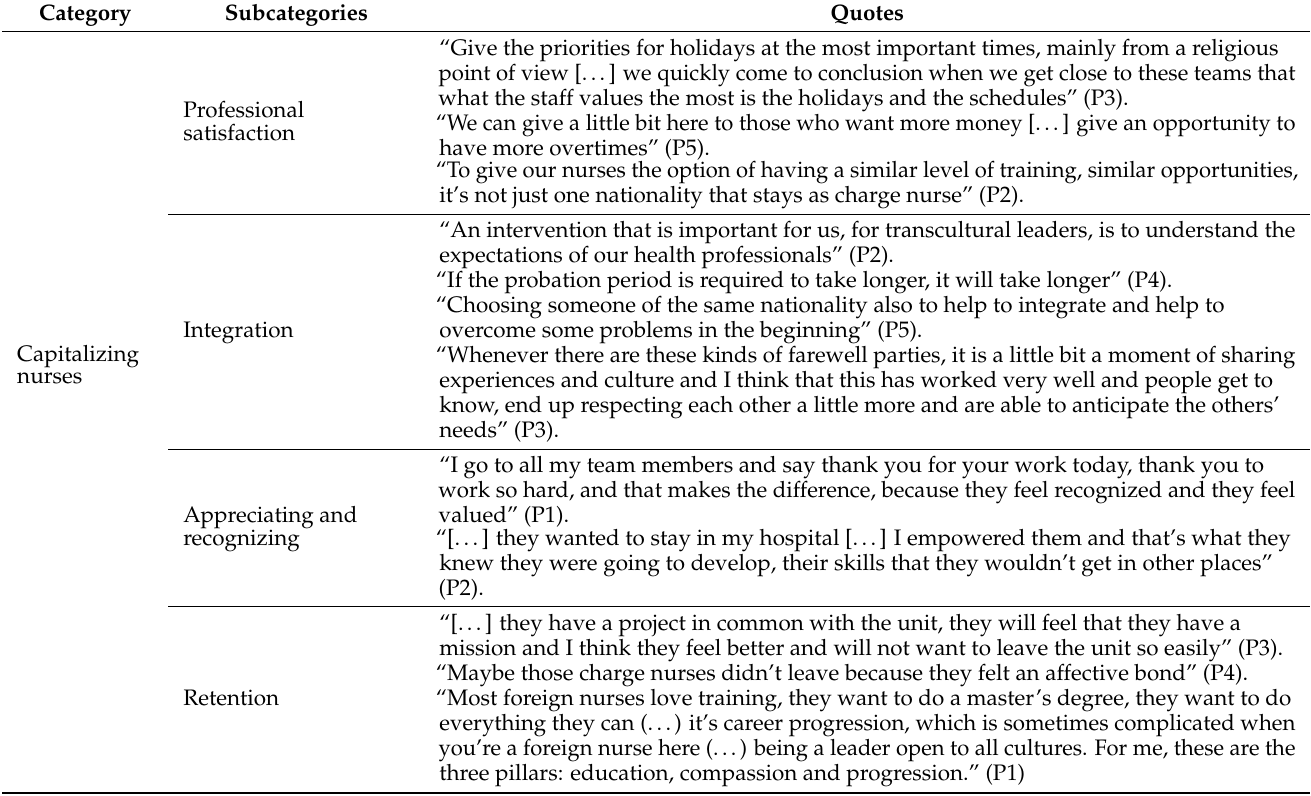
Table 2. Subcategories of the “Capitalizing nurses” category and participants’ quotes.